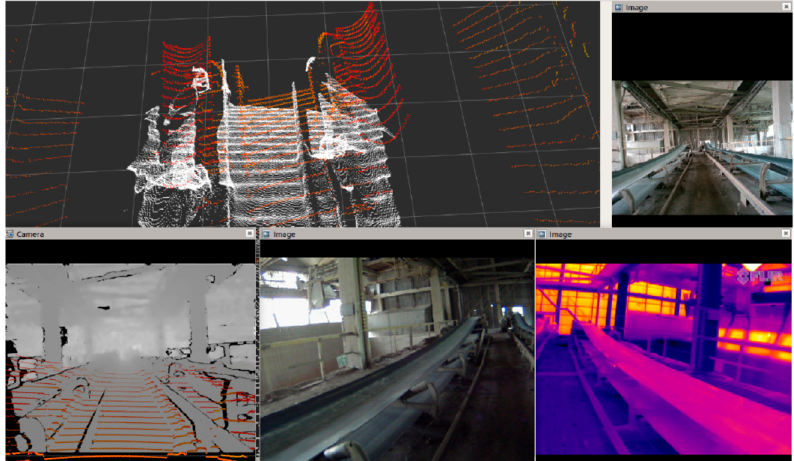
Figure 18. View in Rviz of recorded data during inspection. ( top left ): Depth camera data (gray) and lidar scan lines (red); ( top right ): Front overview; ( bottom left ): Depth camera data and lidar scan lines mapped onto 2D frontal view; ( bottom center ): RGB camera frame; ( bottom right ): IR camera frame (flipped horizontally) (Reprinted from Ref. [110]).